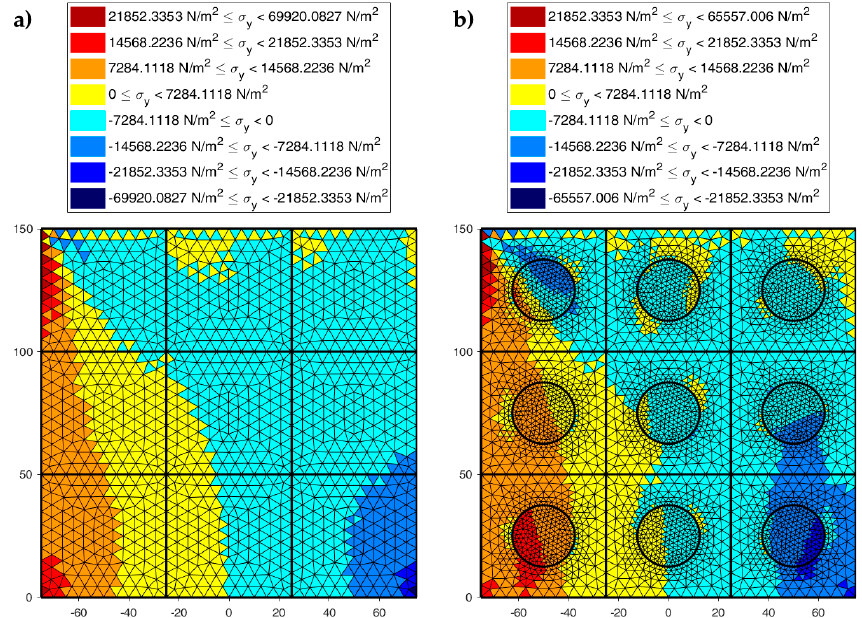
Figure 22. Normal stresses σ y (the y -axis runs vertically) in the discrete elements of a 3 × 3 array subjected to shear load: ( a ) Without inclusions and ( b ) with round inclusions, which are stiffer than the matrix.